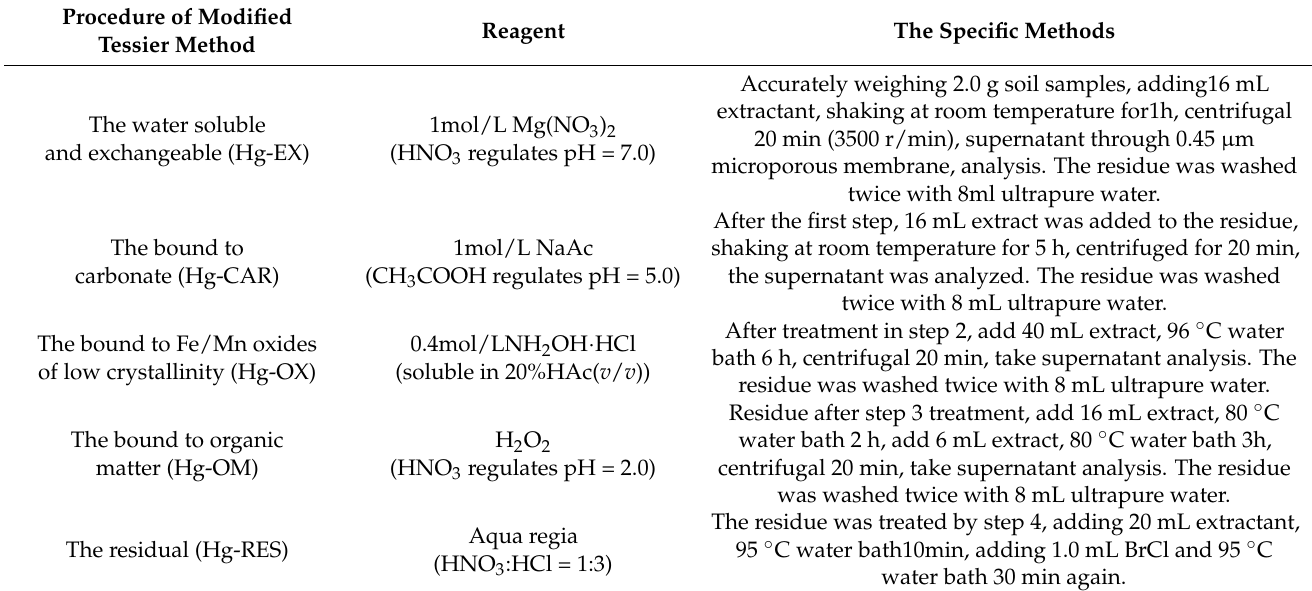
Table 1. Procedure of an optimized Tessier’s sequential chemical extraction